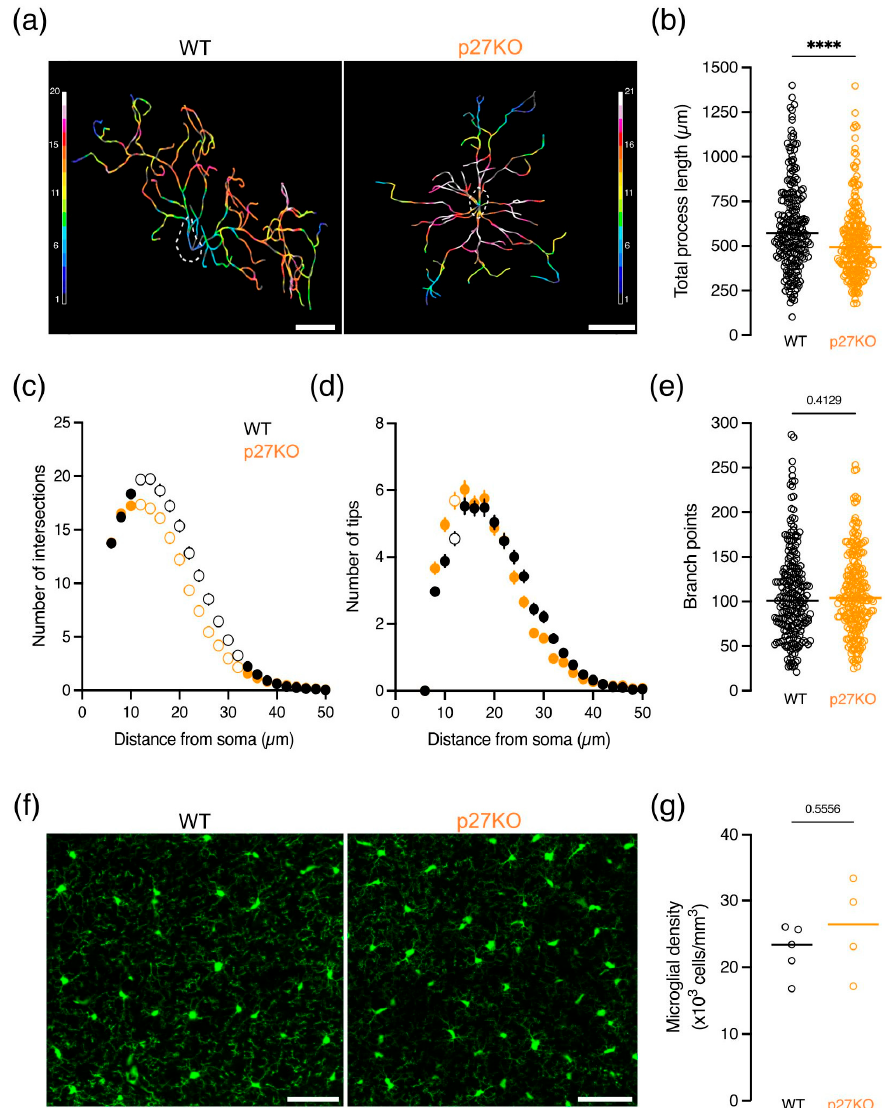
Figure 2. p27 knockout microglia exhibit less ramified processes. ( a – e ) Morphology analysis of microglia from perfusion-fixed P21 CX3CR1 eGFP/+ p27WT (230 cells, 5 mice) and CX3CR1 eGFP/+ p27KO (223 cells, 4 mice) mice showing: ( a ) Representative 3D skeletonized microglia from postnatal day 21 p27WT and p27KO microglia. Color coding represents the number of intersections (soma centered). Scale bar = 10 µ m; ( b ) Total process length; ( c ) Number of process intersections at a specific distance from the soma; ( d ) Number of tips (terminal points); and ( e ) Branch points. ( f ) Representative images of perfusion-fixed P21 CX3CR1 eGFP/+ p27WT and CX3CR1 eGFP/+ p27KO cortical microglia in brain slices. Scale bar = 50 µ m. ( g ) Average microglial density in the cortex of 5 p27WT and 4 p27KO brains. **** p < 0.0001. Mann–Whitney U test. Graphs ( b , e ) represent individual microglia. Horizontal bars represent the median. Empty data points in ( c , d ) represent significant differences ( p < 0.0001). See also Figures S2 and S3.